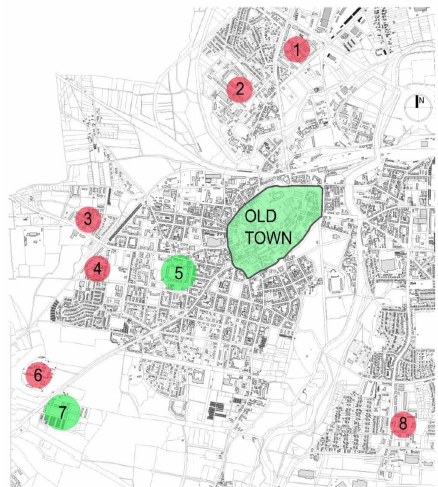
Figure 1. Arrangement of the barracks of Legnica in relation to the historic old town (city center and analyzed barracks marked green): 1 at Pozna´nska street (Scharnhorst Kaserne); 2 at Słubicka street (Ziethen Kaserne); 3 at Chojnowska street (Füsilier Kaserne); 4 at Kawaleryjska street; 5 at Hutnik ó w street (Grenadierkaserne); 6 garrison lazaret at Złotoryjska street; 7 at Złotoryjska street (Kasernen Siegeshöhe); 8 at Rzeczypospolitej lane (Funkerkaserne) (by M.